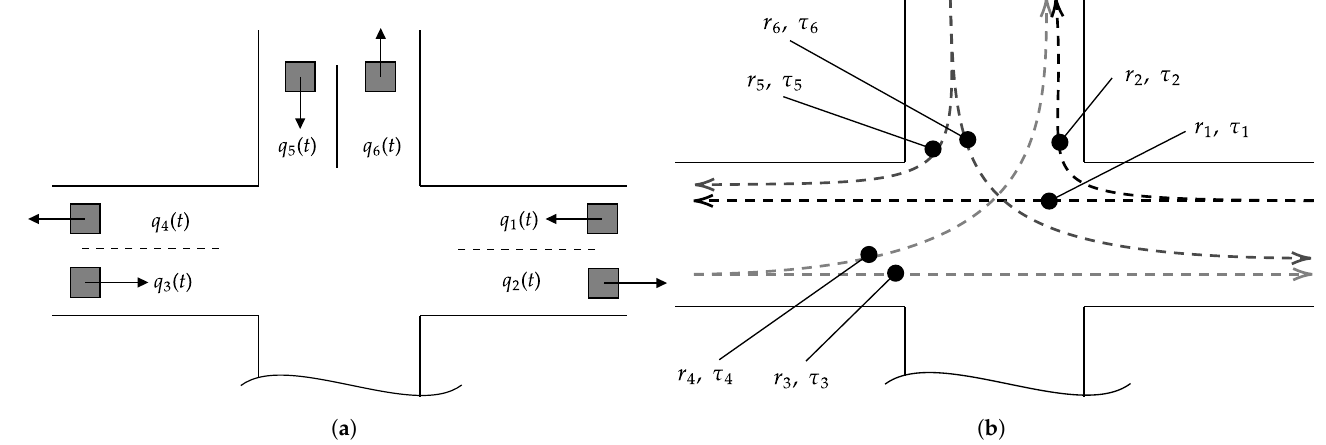
Figure 1. Defined quantities for derivation of traffic flow and travel time: ( a ) measurement spots to derive traffic flow q s ( t ) for all s = { 1,2,3, 4,5,6 } , ( b ) pre-defined routes r = { 1,2,3, 4,5,6 } to derive all travel times τ r ( t )